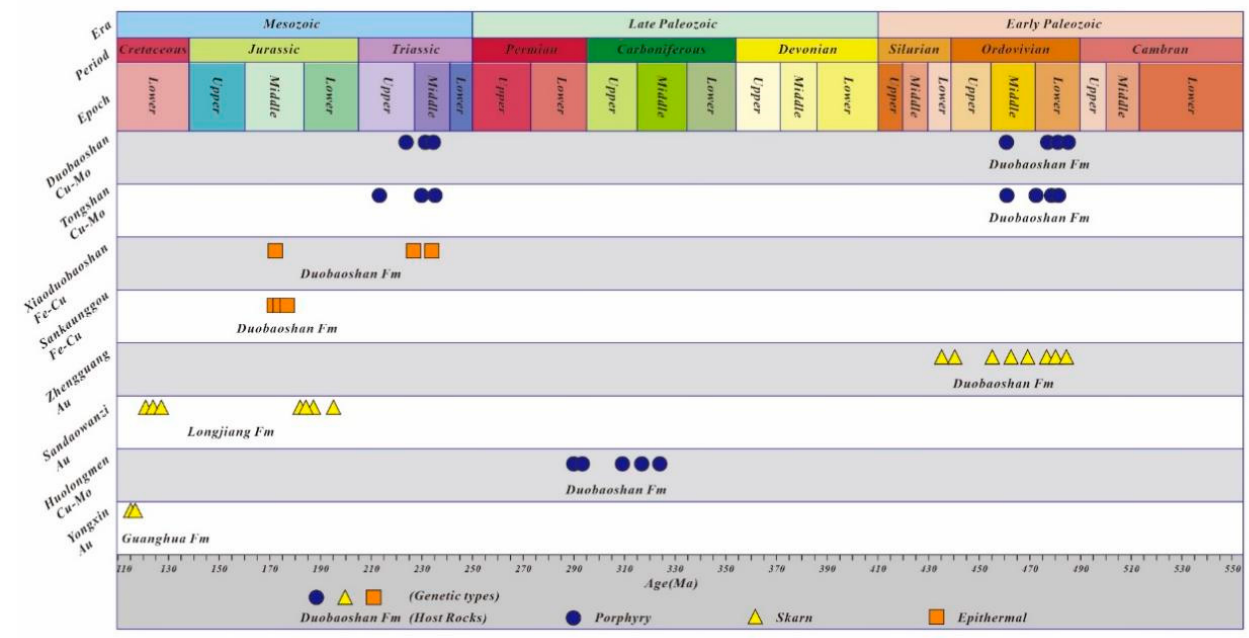
( B ) Regional geological map of the Duobaoshan ore district and adjacent regions. Figure 1. ( A ) Regional geophysical anomalies of the Duobaoshan ore district and adjacent regions.